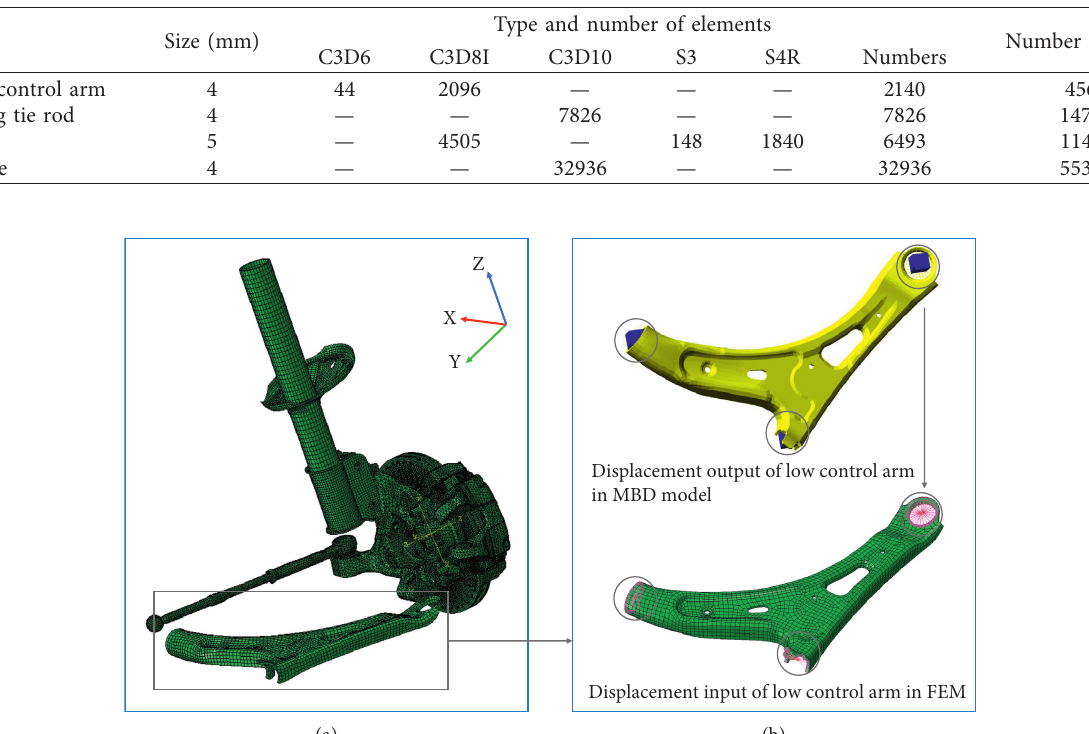
Figure 8: FEM of chassis corner. (a) Chassis corner assembly. (b) Example of values